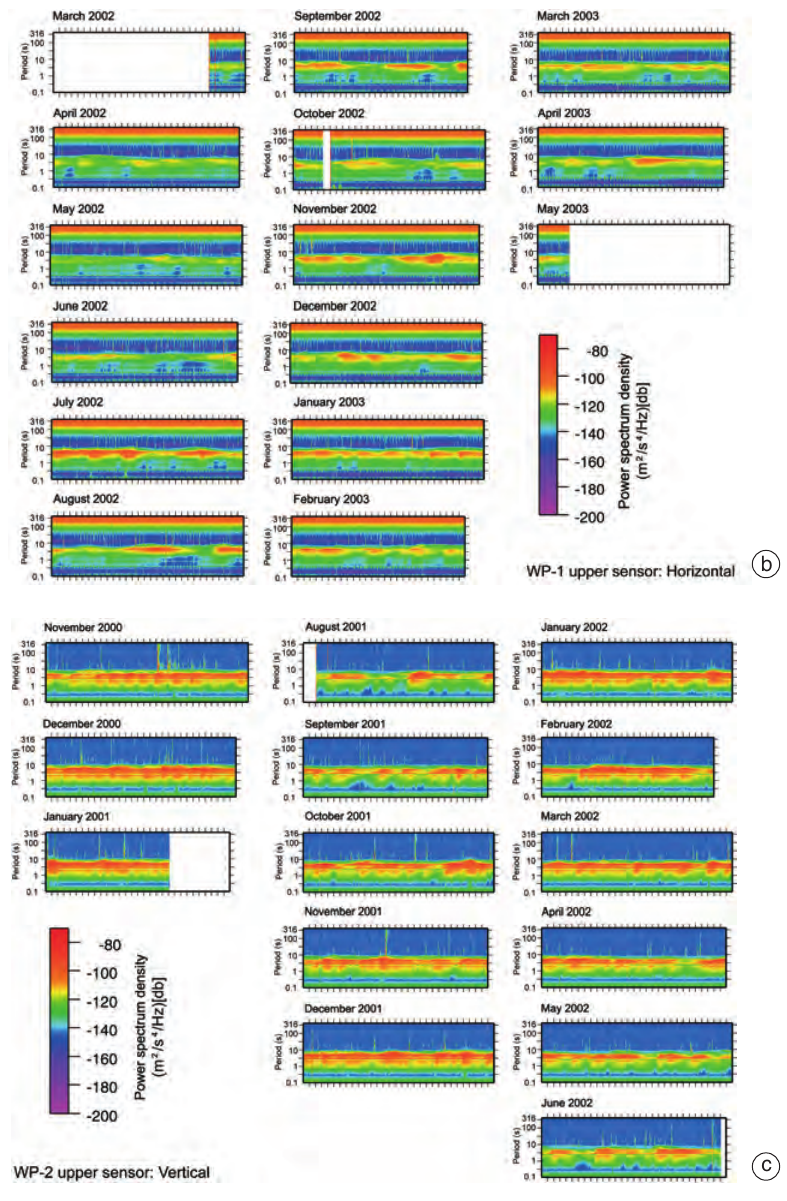
Fig. 7b,c. Running spectra of the records from the deep-sea borehole observatories. Each spectrum is calculated with a moving time window for a total of one hour record. b) Spectra for the horizontal component of WP-1. A to- tal of 408 days of continuous data were obtained form the WP-1 Observatory. c) Spectra for the vertical component of the WP-2 Observatory. A total of 417 days of continuous data were retrieved from WP-2. There is little change in noise levels above 10 s period. Many earthquakes are visible on the running spectra in periods greater than 10 s. Small temporal variations (maximum fluctuation is 10 dB) of noise levels for periods around a few seconds are